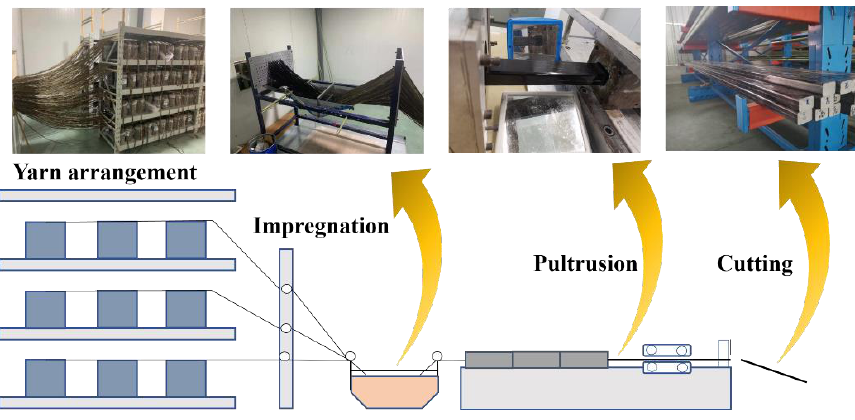
Figure 1. Core rods preparation process.